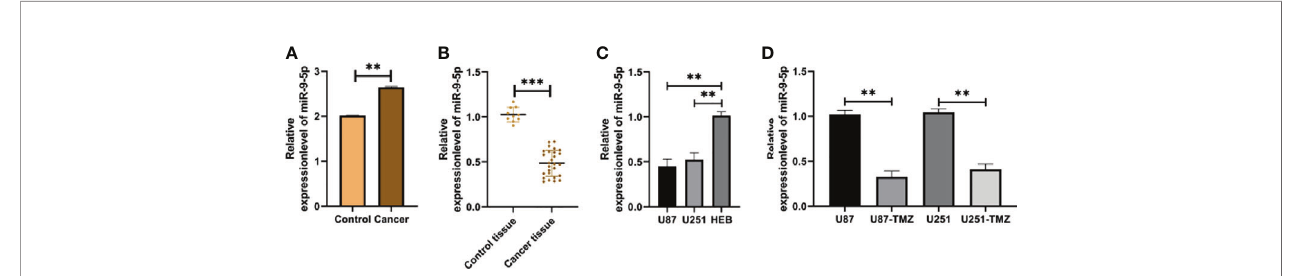
FIGURE 1 | ExpressionofmiR-9-5pinglioma. (A) RelativeexpressionofmiR-9-5pinTMZ-resistantcellsinGEOchip. (B) qRT-PCRwasusedtodetecttherelative expressionofmiR-9-5pintumortissuesofpatientswithglioma. (C) qRT-PCRwasusedtodetecttherelativeexpressionofmiR-9-5pingliomacells. (D) Theexpressionof